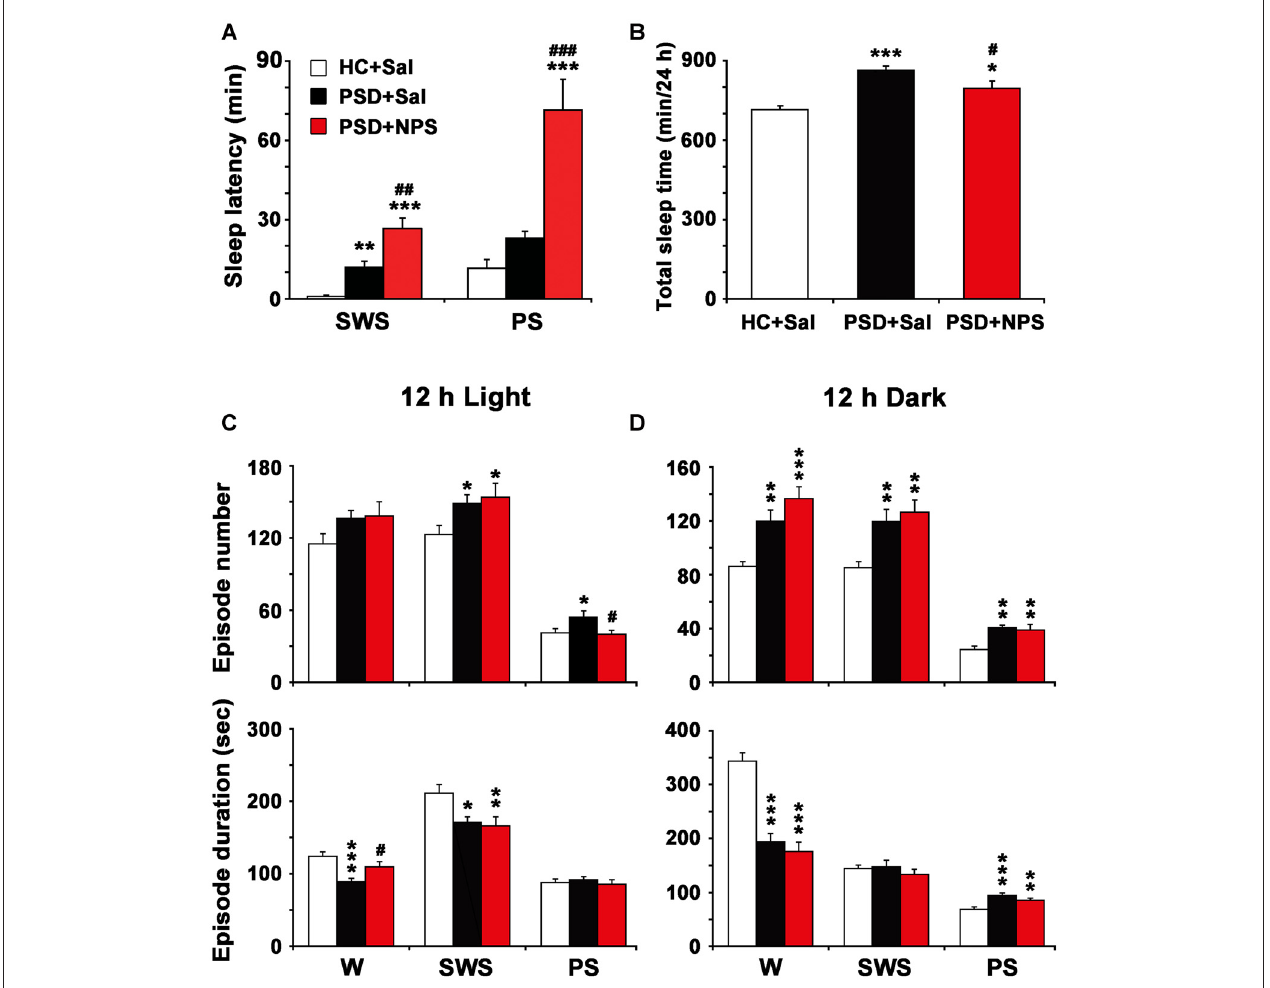
FIGURE 5 | Sleep latency (A) , total sleep time in 24 h (B) and episode number and duration of each stage during 12 h light (C) and 12 h dark periods (D) . Values are the means ± SEM ( n = 8–9). ∗ P < 0.05, ∗∗ P < 0.01, ∗∗∗ P < 0.001 compared to HC + Sal; # P < 0.05, ## P < 0.01, ### P < 0.01, compared to PSD + Sal. Statistics were analyzed by one-way ANOVA and followed by Fisher’s LSD